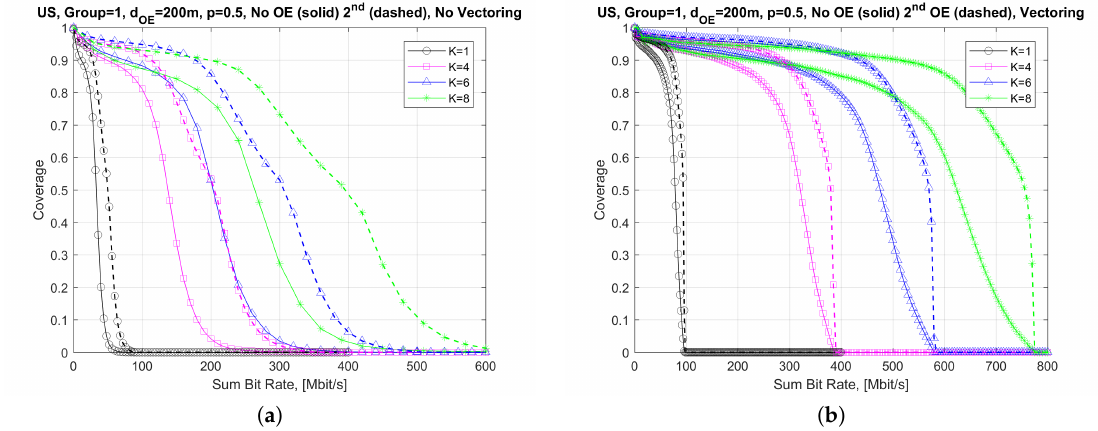
Figure 8. Sum bit rate coverage for group 1, d OE = 200 m—variable of number of pairs per radio node, user activity factor, p = 0.5, US with non-vectoring ( a ) and US with vectoring ( b ).